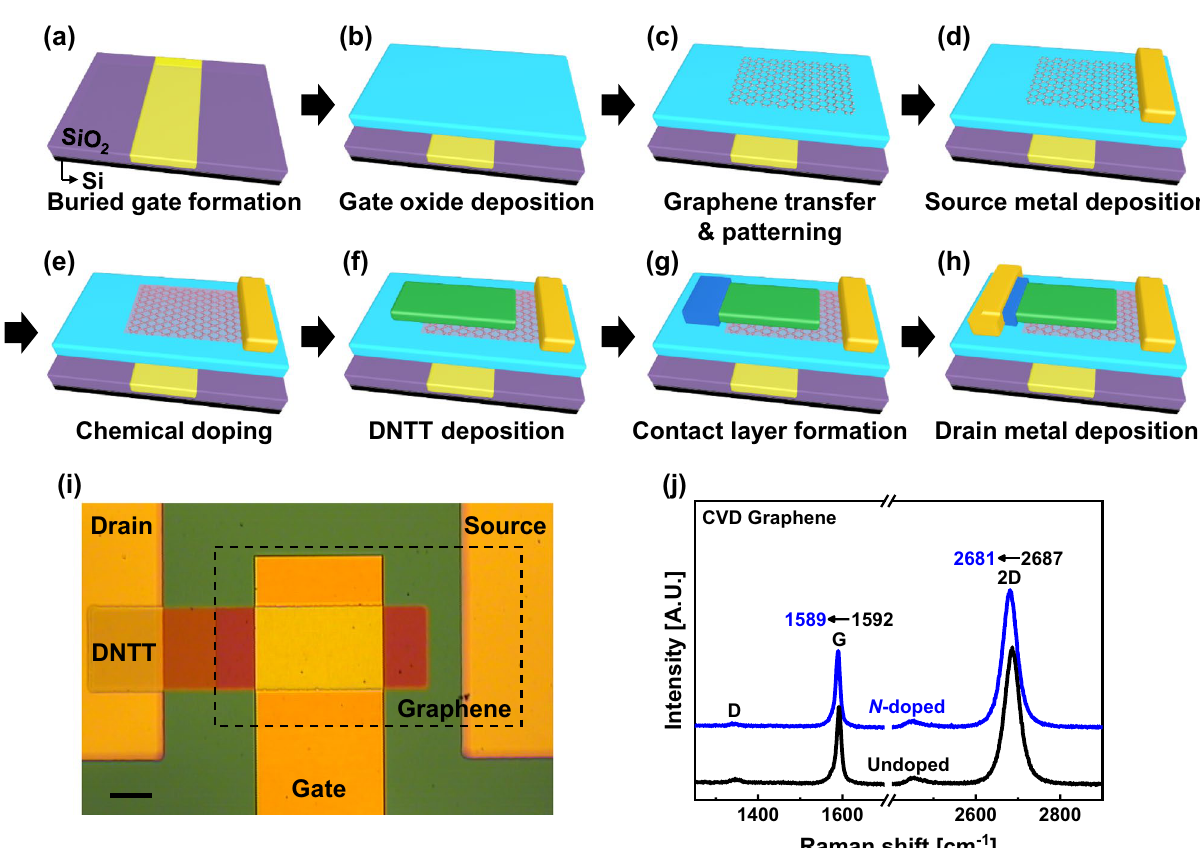
Figure 1. ( a – h ) Schematics of the fabrication process for a p -type graphene barristor with graphene chemical doping and a CRL/CDL. ( i ) Optical image of the fabricated device. ( j ) Raman spectra of CVD graphene with PEI concentrations of 0 and 0.01 wt% as undoped and n -doped,